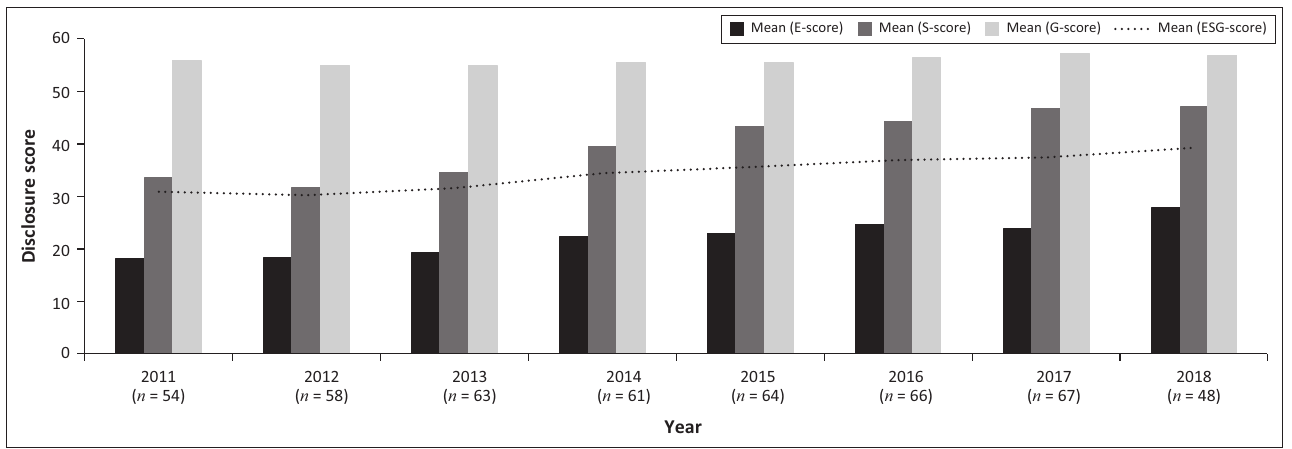
FIGURE 1: Annual mean values for the composite and individual environmental, social and corporate governance disclosure scores.